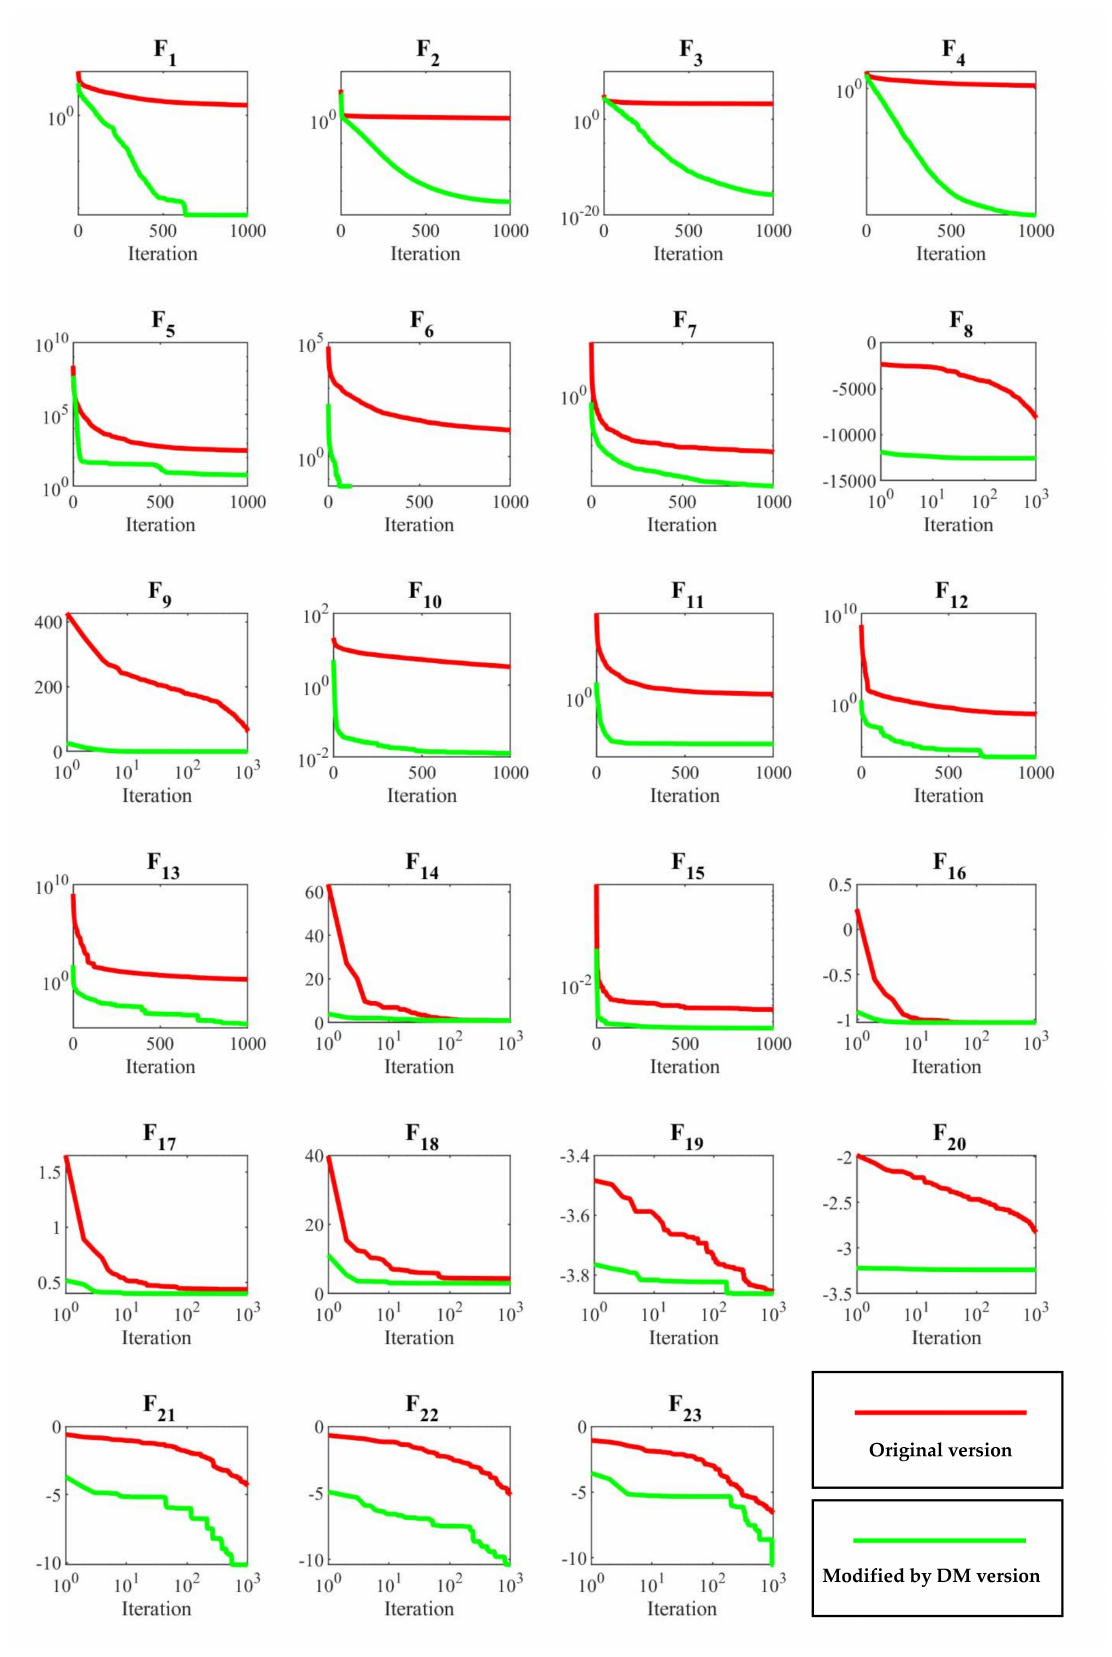
Figure 3. The convergence curves of GA for original and “modified by DM”